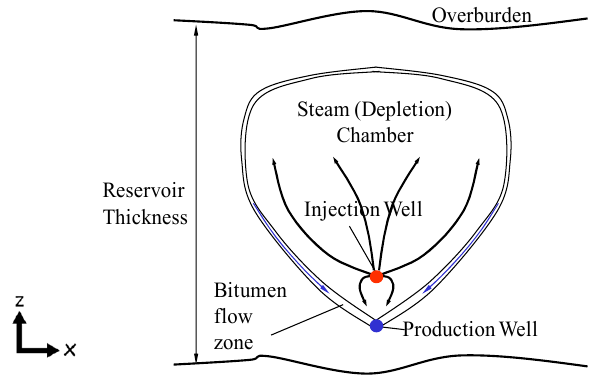
Figure 1. Cross-sectional view of the steam-assisted gravity drainage (SAGD) process.